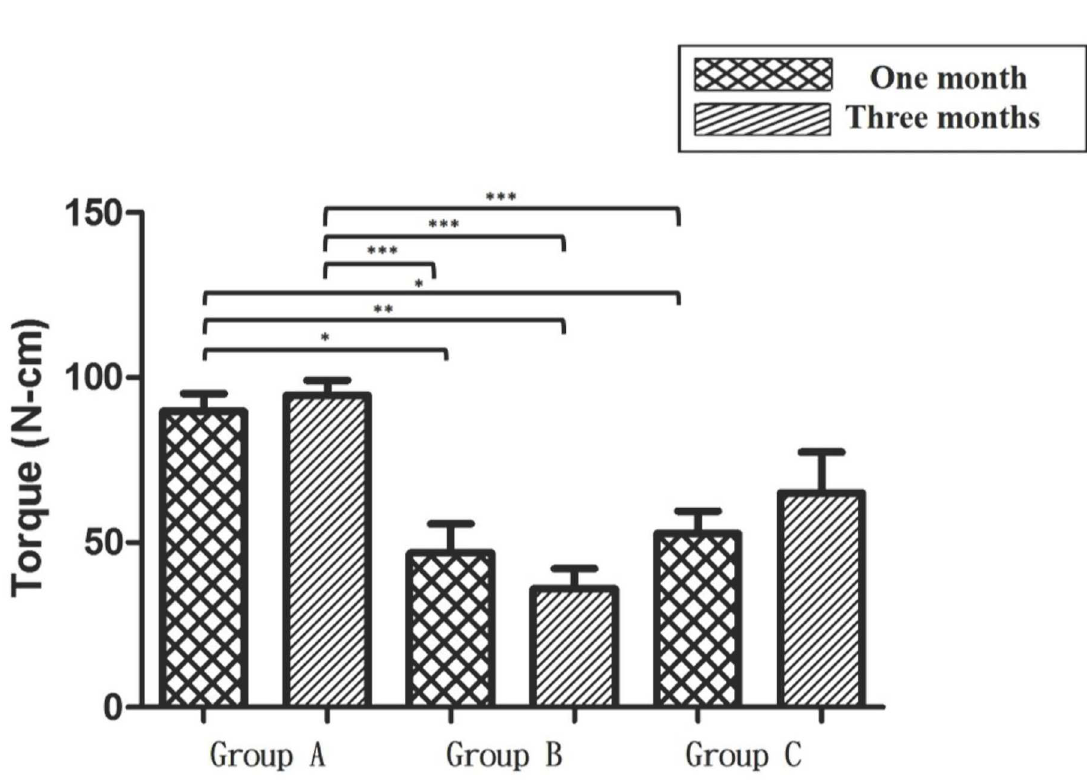
Fig 9. Comparison of peak insertional torques of different cortex screws in cortical bones after implantation. Group A: SLAffinity group, Group B: commercialgroup, Group C: sand-blasted group. * : p < 0.05, ** : p < 0.01, and *** : p < 0.001. https://doi.org/10.1371/journal.pone.0188364.g009 PLOS ONE | https://doi.org/10.1371/journal.pone.0188364 November17,